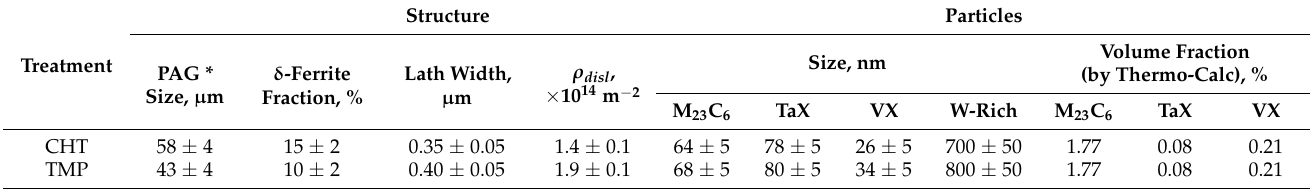
Table 9. Structural parameters of the 12CrTaNb0.02N